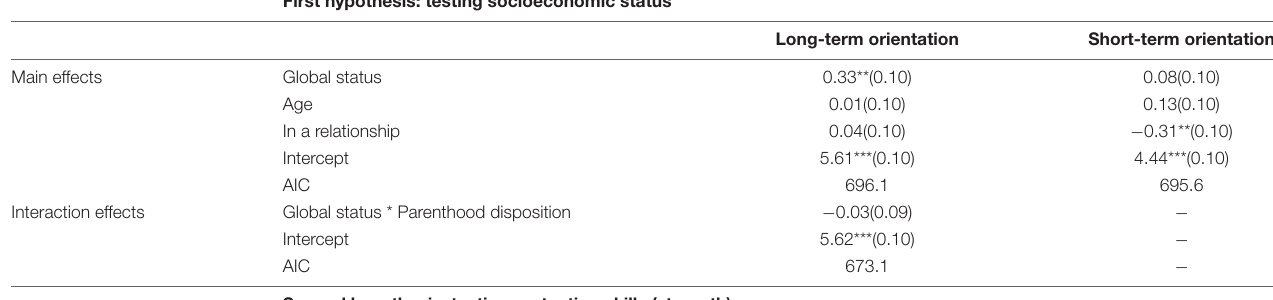
TABLE 3 | Generalized linear models, standardized coefficients and standard errors for long and short-term sociosexual orientation ( N = 197). First hypothesis: testing socioeconomic